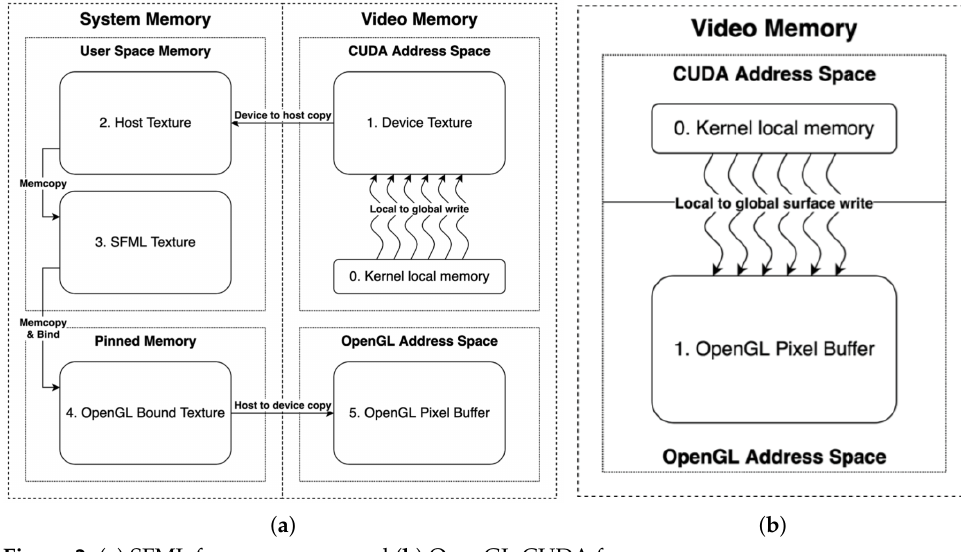
Figure 2. ( a ) SFML frame memory, and ( b ) OpenGL-CUDA frame